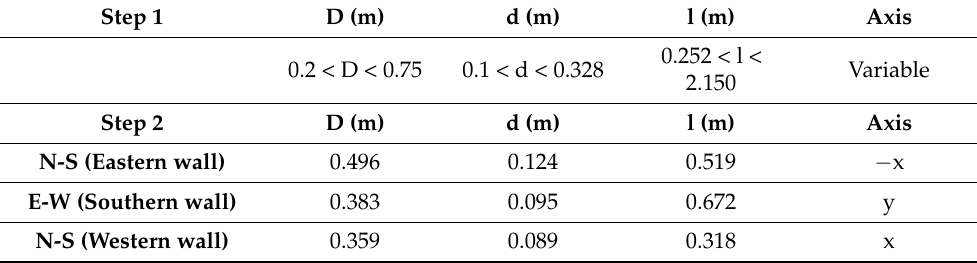
Table 2. Parameters used for detecting morphological point cloud changes for Step 1 and Step